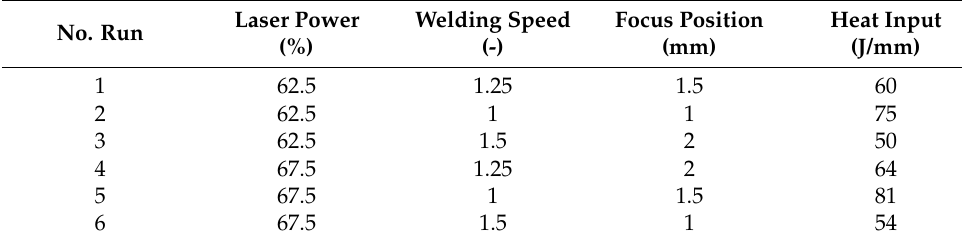
Table 2. Nd-YAG Laser welding process parameters.